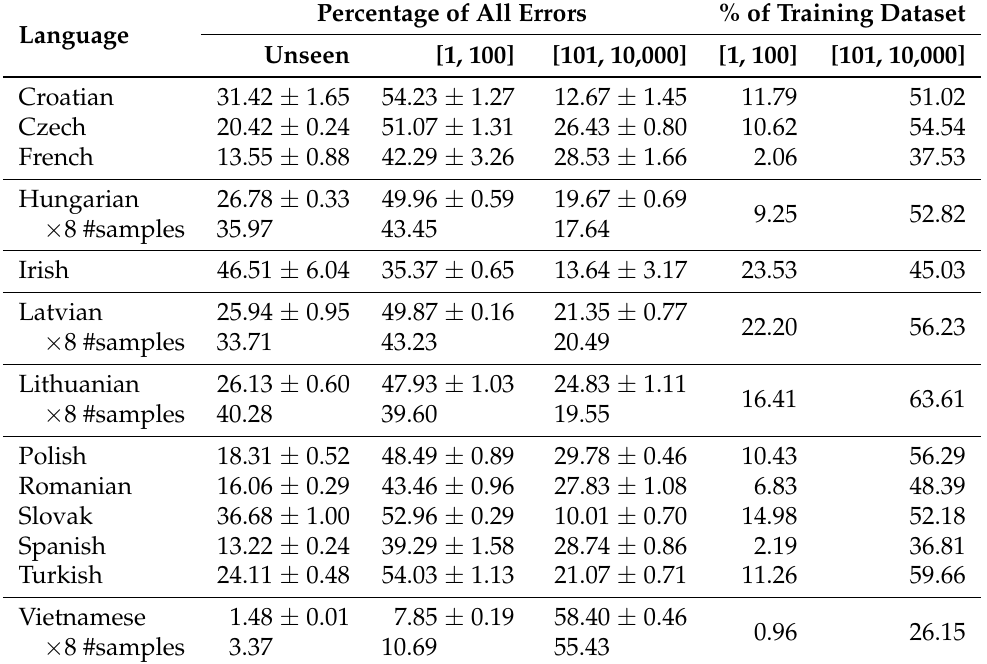
Table 6. The distribution of diacritics restoration errors for the different frequencies of the words in the training dataset are shown in the first three columns. The intervals indicate the bounds of how many times the words in this group were encountered in the training dataset. The last two columns indicate the percentages of how much of the training dataset was constituted by these word